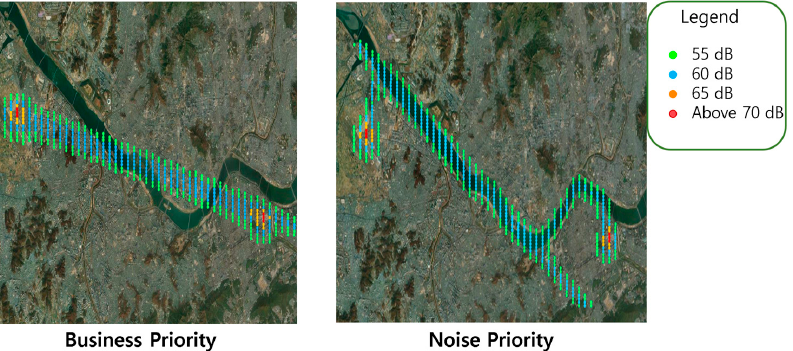
Figure 14. Noise maps for two different scenarios.